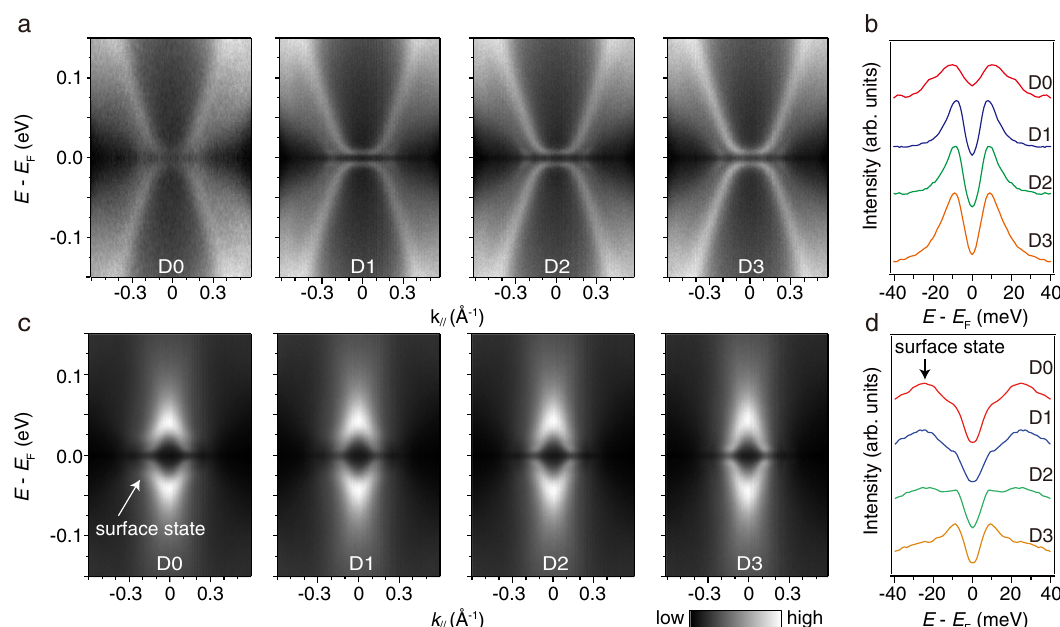
Fig. 2 Band evolution in potassium-coated BaFe 2 (As 0.7 P 0.3 ) 2 . a Doping dependence of the symmetrized energy-momentum cuts taken around the Γ point. E − E F represents the binding energy of electrons. E is the kinetic energy of electrons and E F is the Fermi energy. k // is the in-plane momentum of electrons. b Doping dependence of the symmetrized energy distribution curves (EDCs) taken at the Fermi crossing ( k F ) of the α hole band. Panels c and d are the same as a and b but taken around the Μ point. The EDCs are taken at the k F of the δ electron band. The deposition sequence is denoted using Dn ( n is the doping